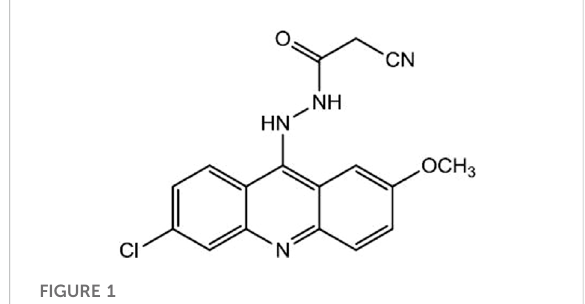
FIGURE 1 Chemical structure of acridine derivative